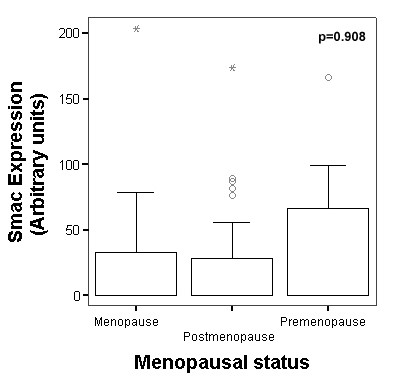
Smac expression levels versus menopausal status of cervical cancer samples. Graph shows median, upper and lower quartiles. P value testing the significance of the difference by ANOVA.